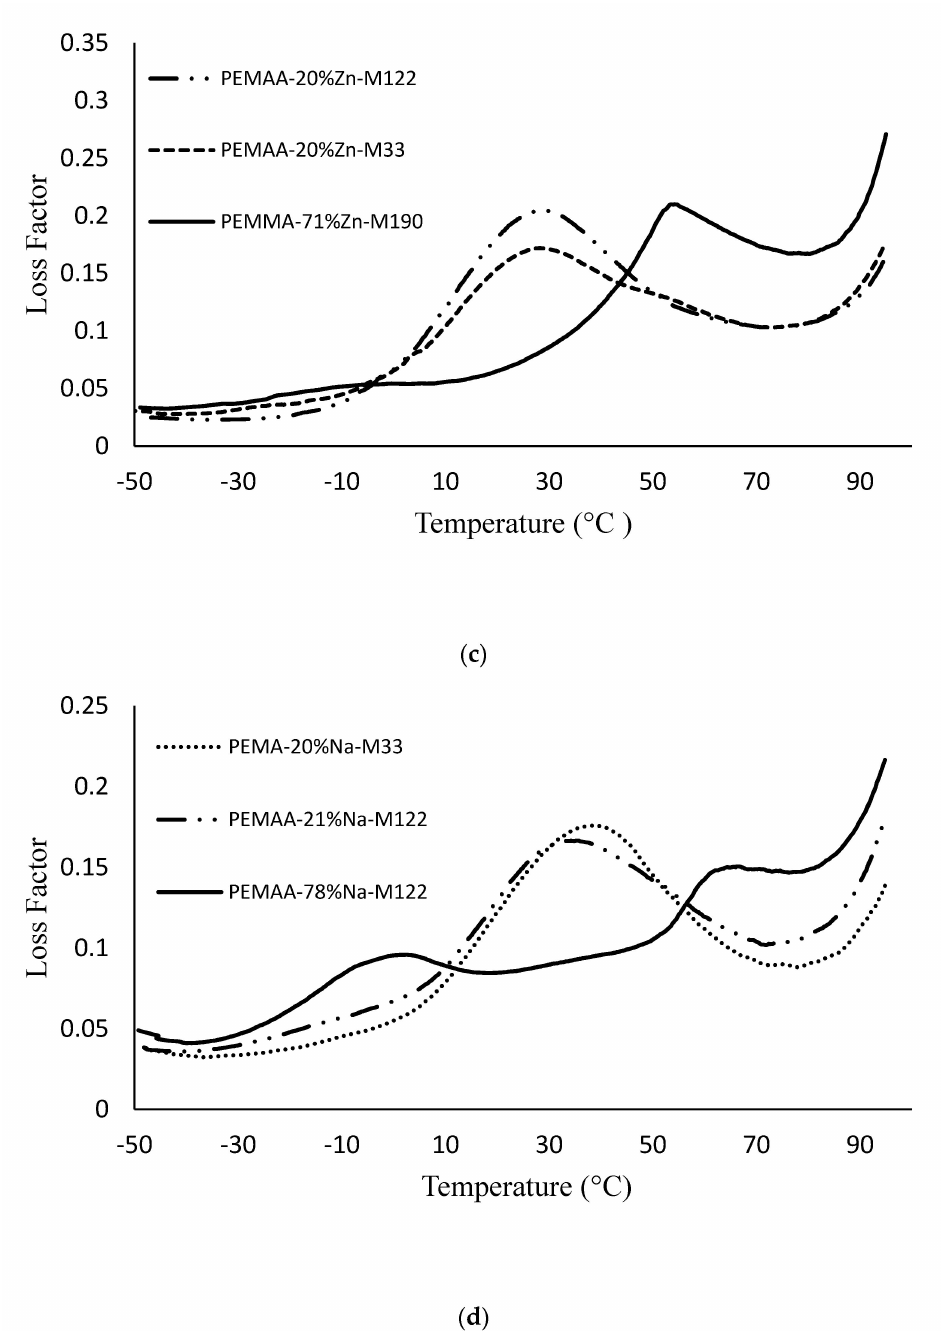
Figure 9. The loss factor obtained from DMA run for PEMAA neutralized at various percentages by ( a ) Li, ( b ) Mg, ( c ) Zn, and ( d )